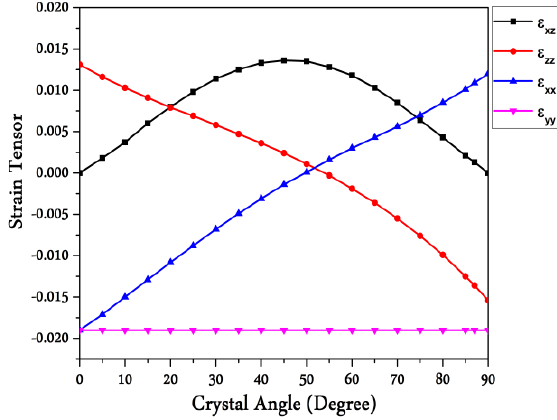
Figure 5. Strain tensor components as a function of crystal angle for 17% In composition.